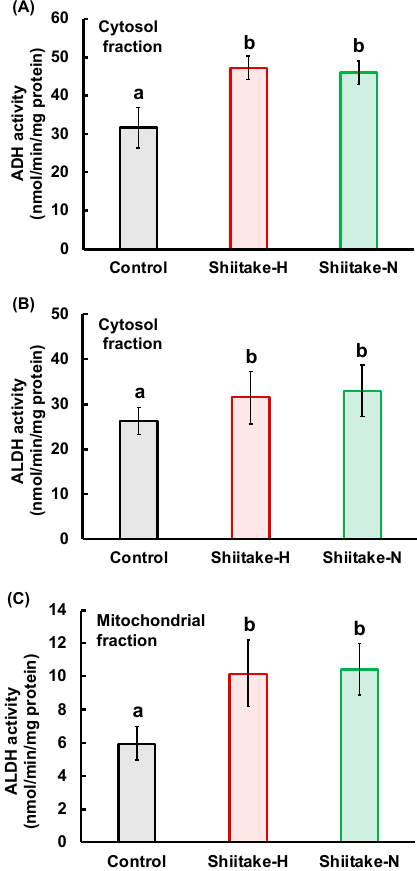
Figure 6. E ff ect of shiitake extract on ADH and ALDH activities in the liver. ( A ) ADH activity in cytosol fraction ( n = 4); ( B ) ALDH activity in cytosol fraction ( n = 4); ( C ) ALDH activity in mitochondrial fraction ( n = 6). Results with di ff erent letters are significantly di ff erent at p < 0.05. Data are the means ± S.D. ADH: alcohol dehydrogenase, ADLH: aldehyde